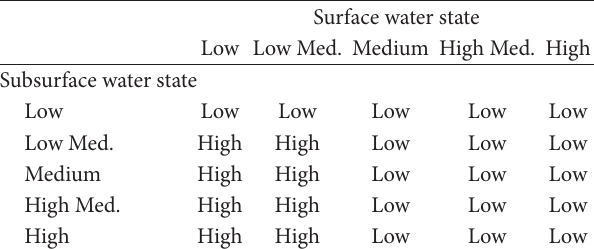
Table 1: Rule table for the operation in conjunctive use operation using FIS within high usage of subsurface